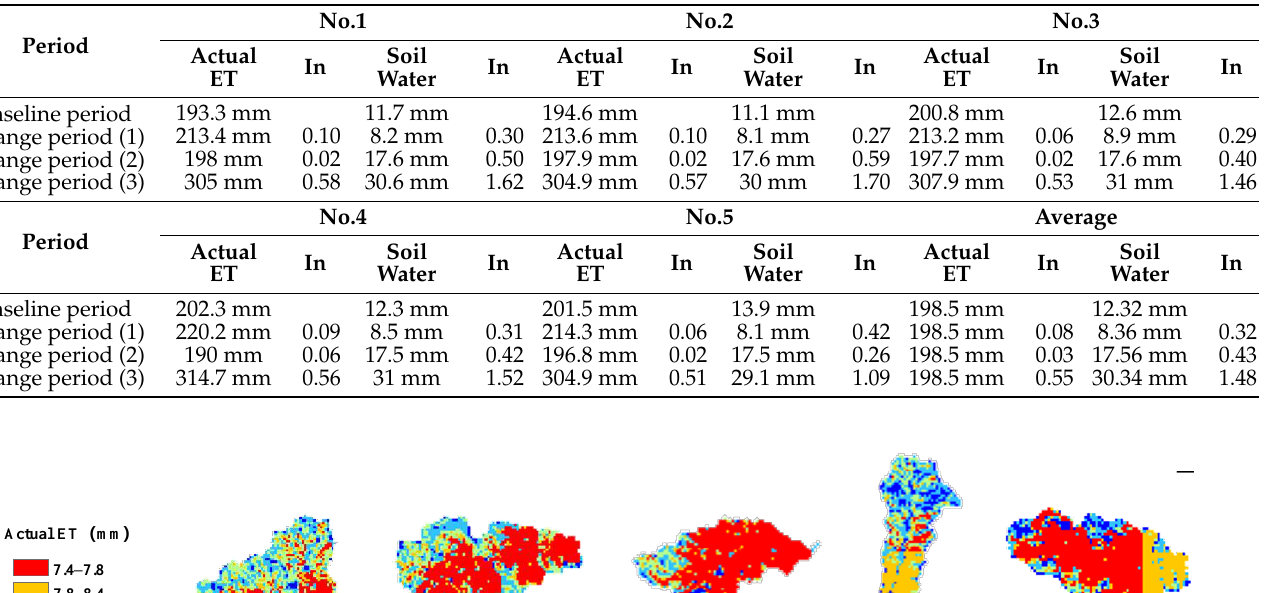
Table 10. Simulated evaporation and soil water in sub-watershed controlled by five large-scale silt dams (In = increase).